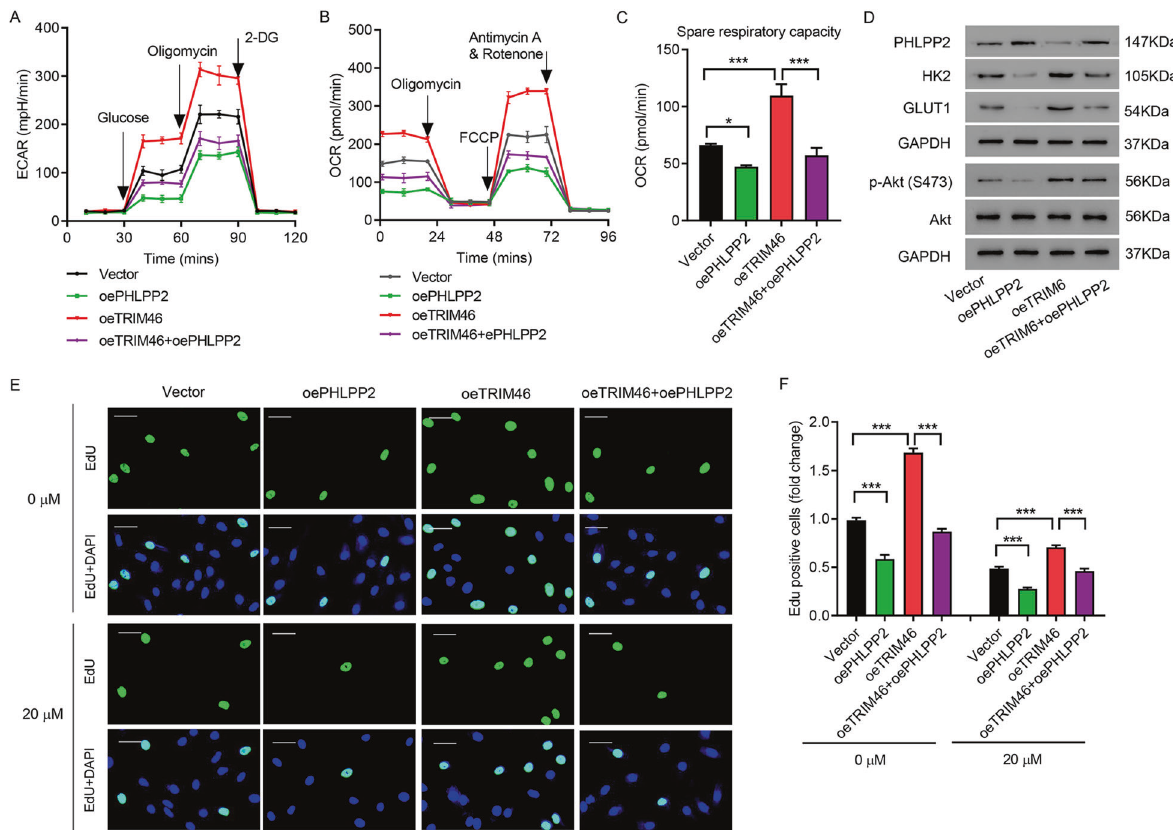
Fig. 6 Overexpressing PHLPP2 overexpression abolished the effects of TRIM46 overexpression. A ECAR, B OCR, C spare respiratory capacity and D expression of PHLPP2, AKT, p-AKT, HK2, and GLUT1 of A549 cells transfected with TRIM46, PHLPP2, or TRIM46 plus PHLPP2. A549 cells were transfected with PHLPP2/TRIM46 and treated by DDP (20 μ M). E A549 cell proliferation measured by EdU staining (scale bar: 50 μ m). F Statistical analysis of EdU positive A549 cells. Results were presented as the mean ± standard error ( n = 3). Independent experiments were repeated three times. * P < 0.05, *** P <